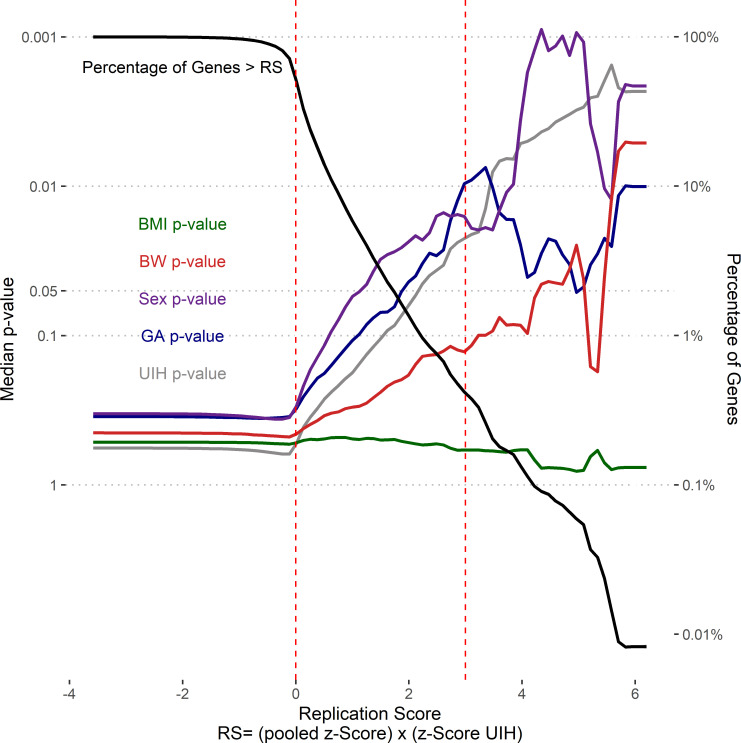
Replication score enriches for genes associated with multiple risk factors.Splines (colored according to analysis) of median p-values (left y-axis) for genes with replication scores greater than corresponding cut-off (x-axis). Percentage of genes with replication score greater than corresponding cut-off. Vertical dashed lines two cutoffs: RS > 0 and RS > 3.